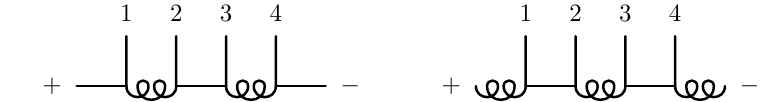
Figure 5 . The one-loop half integrand in (4.12) has contributions from forward limits of tree-level half integrands associated to diagrams with six scalars and a double trace.